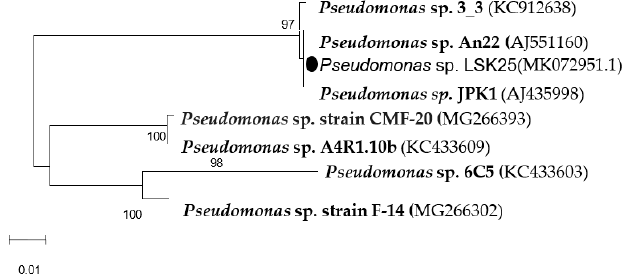
Figure 3. Unrooted Neighbour Joining tree illustrating the relationship of strain Pseudomonas sp. LSK25 ( ) with other Pseudomonas sp. strains obtained from the polar regions.